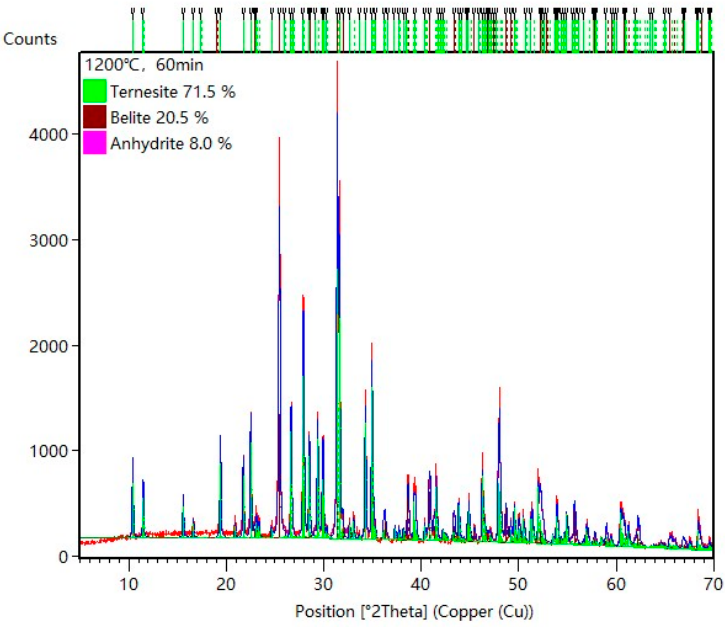
Figure 6. Rietveld refinement of XRD pattern for the sample calcined at 1200 ◦ C for 60 min.